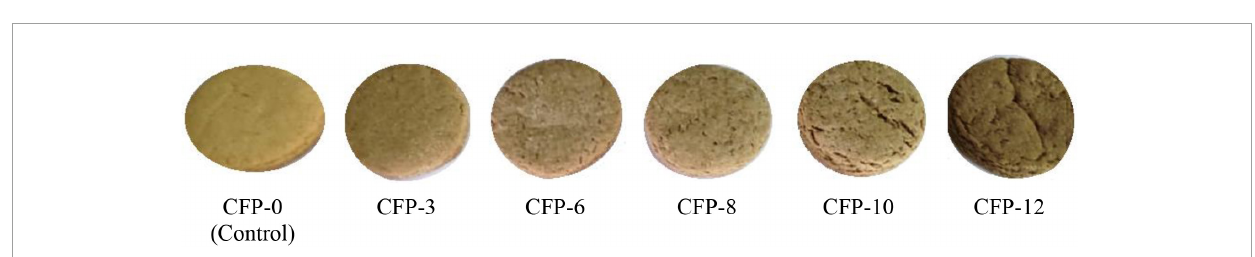
FIGURE2 Sensory attributes of fortified cookies using 9-points hedonic scale (1 = extremely dislike, 2 = very much dislike, 3 = moderately dislike, 4 = dislike-slightly, 5 = neither-like nor-dislike, 6 = like-slightly, 7 = like-moderately, 8 = like-very much, 9 = like-extremely). CFP-0 = Cookies fortified with 0 g PP powder (control), CFP-3 = Cookies fortified with 3 g PP powder, CFP-6 = Cookies fortified with 6 g PP powder, CFP-8 = Cookies fortified with 8 g PP powder, CFP-10 = Cookies fortified with 10 g PP powder, CFP-12 = Cookies fortified with 12 g PP powder.